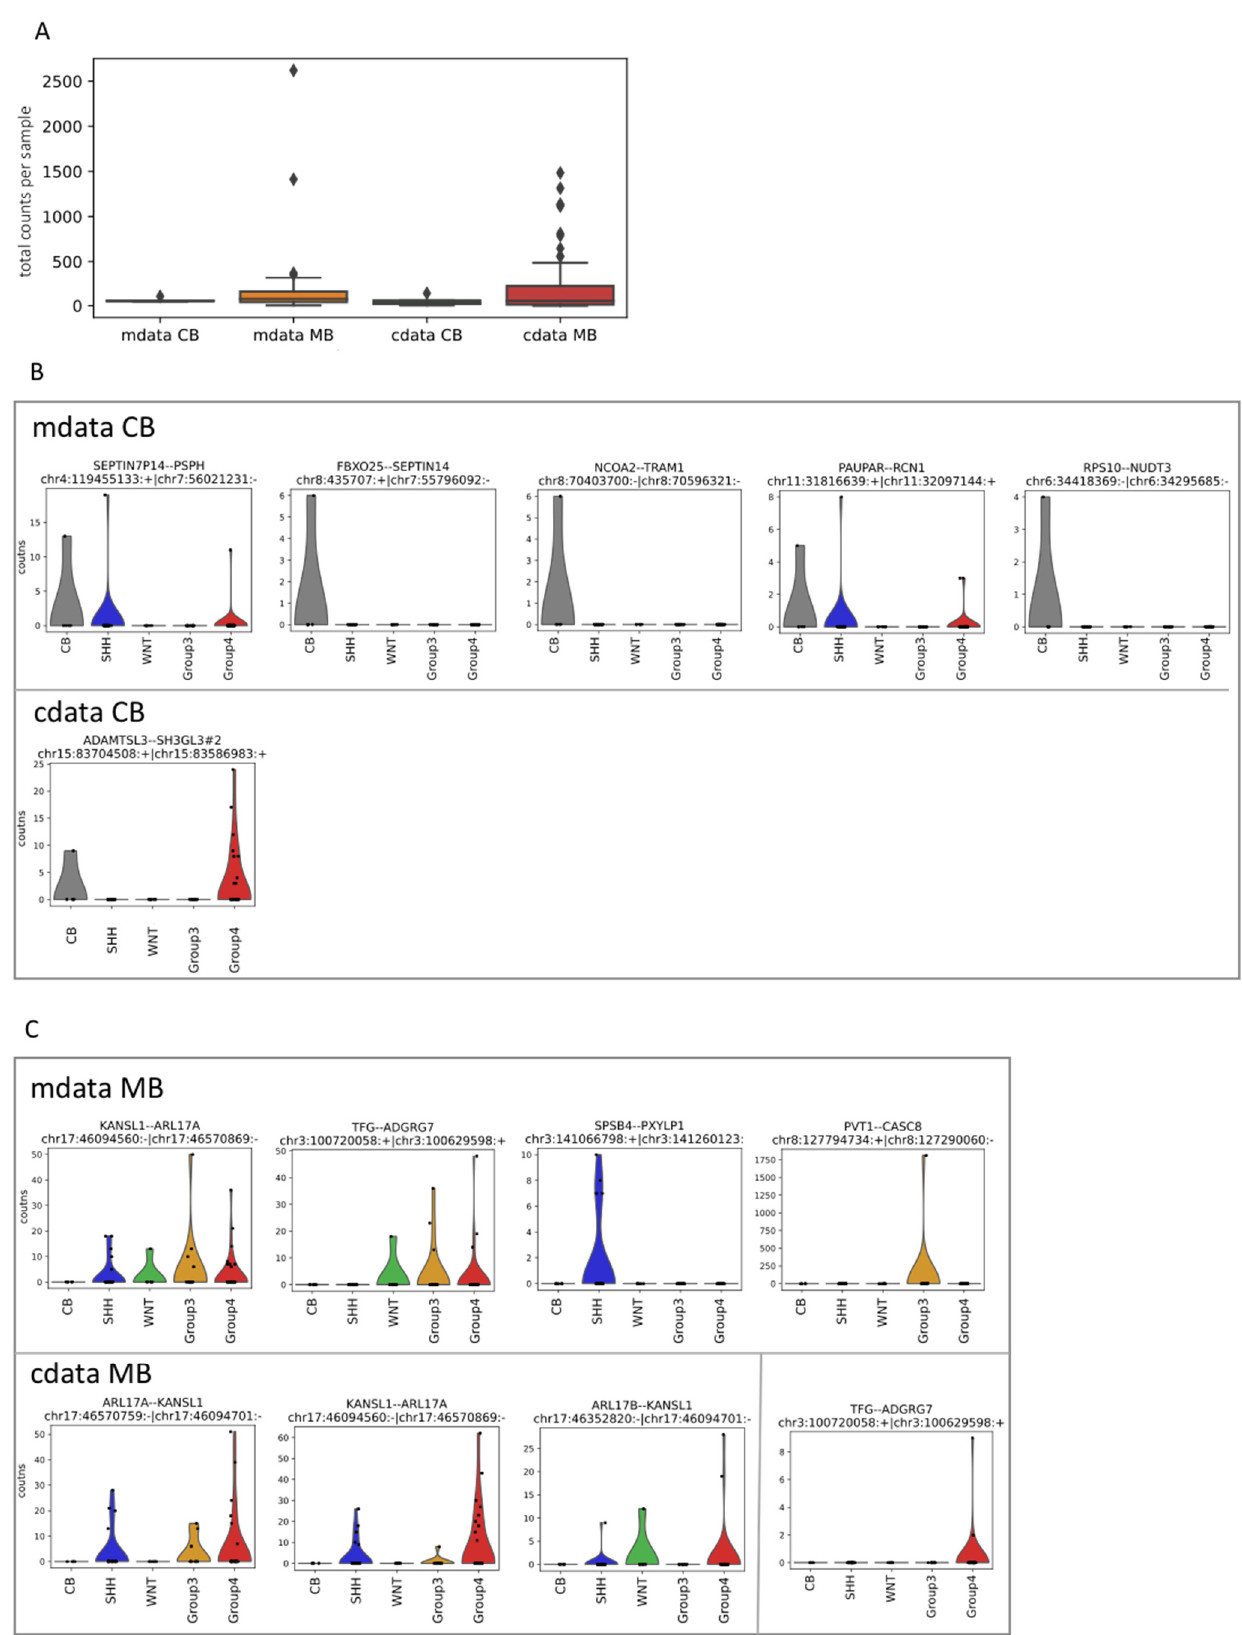
Figure 2. Fusion transcripts in linear and circular RNAs from cerebellum and medulloblastoma. ( A ) Box plots of the expression of linear (mdata) and circular (cdata) fusion transcripts in cerebellum